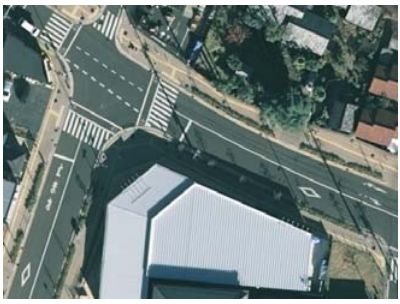
Figure 1. Traffic marking in Japan